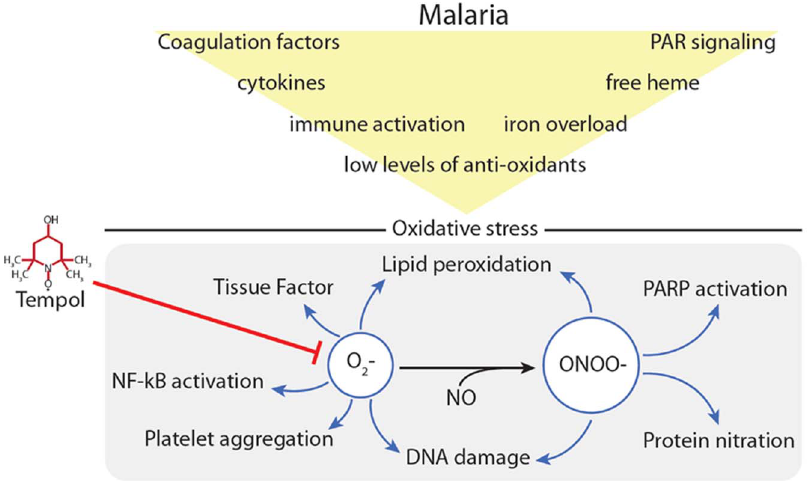
Figure 9. Pathologic events in malaria lead to radical oxygen species (ROS) generation and inflammation. Plasmodium falciparum infection is associated with coagulation and complement activation, cytokine release, host response to infection, and activation of different cells types, including endothelial cells, platelets, dendritic cells and monocytes, and neutrophils. It is also associated with release of Pf -GPI, iron overload, heme release and Fenton reaction, and diminished levels of antioxidants [1–9]. Superoxide contributes to platelet aggregation, tissue factor expression, cytokine release, NF- k B activation, DNA damage, NET formation, recruitment of inflammatory cells, conversion of nitric oxide (NO) to peroxynitrate (ONOO 2 ) which in turn leads to DNA damage, PARP activation, lipid peroxidation, and protein nitration. These events result in sustained inflammation [52–56]. NO, nitric oxide; O 2 2 , superoxide; ONOO 2 , peroxynitrate.